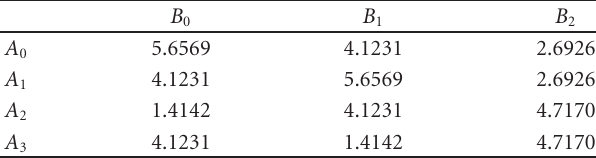
Table 3: Cost matrix of signature A and B .